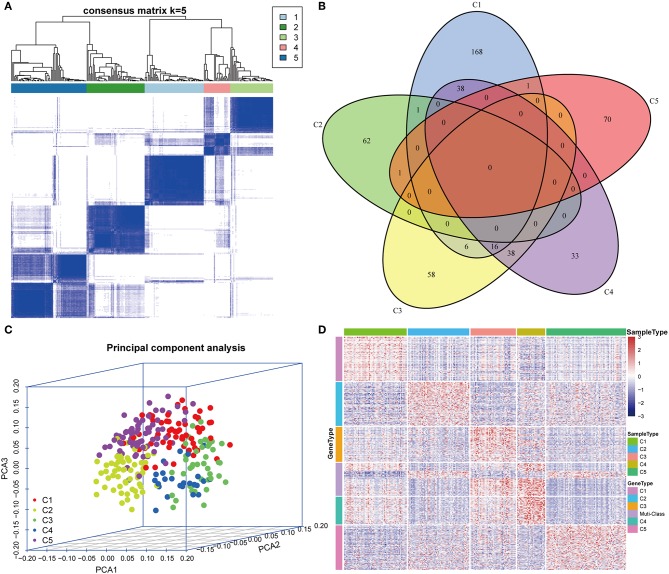
Expression profile analysis of five HCC subtypes. (A) The consensus score matrix of HCC samples when k = 5 (1 = C1, 2 = C2, 3 = C3, 4 = C4, 5 = C5). A high consensus score between two samples suggests that they have higher probability to be grouped into the same cluster in different iterations. (B) Venn diagram of the overlapping significantly upregulated genes in five HCC subtypes. (C) Three-dimensional principal component analysis (PCA) of gene expression profile of the upregulated genes. Each sample is represented with a single point, with different color for each of the five subtypes. (D) Gene expression heatmap analysis of top 100 genes that were significantly upregulated in each subtype. Heat map indicates relative gene expression value, with red for high expression and blue for low expression.